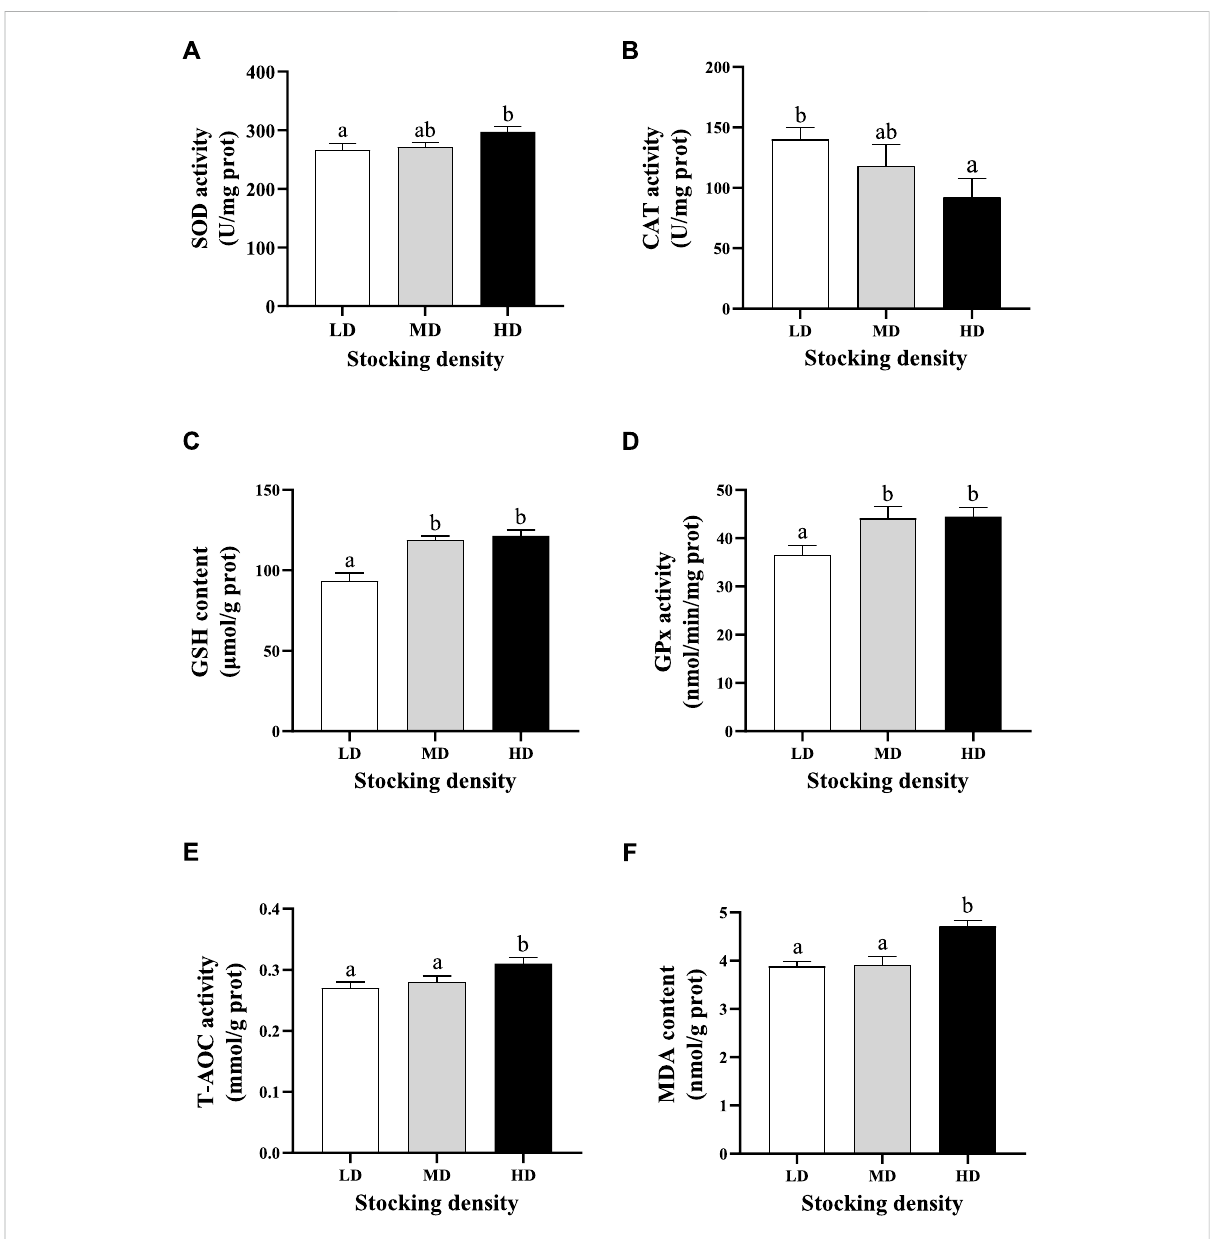
FIGURE 2 Antioxidative parameters in hepatopancreas of C. quadricarinatus under different densities in an integrated rice – shrimp farming system after 90 days. Values are presented as means ± SE ( n = 9). (A) SOD; (B) CAT; (C) GSH; (D) GPx, (E) T-AOC; (F) MDA. Means with different superscripts denote signi fi cant differences ( p < 0.05). LD, low stocking density; MD, middle stocking density; HD, high stocking